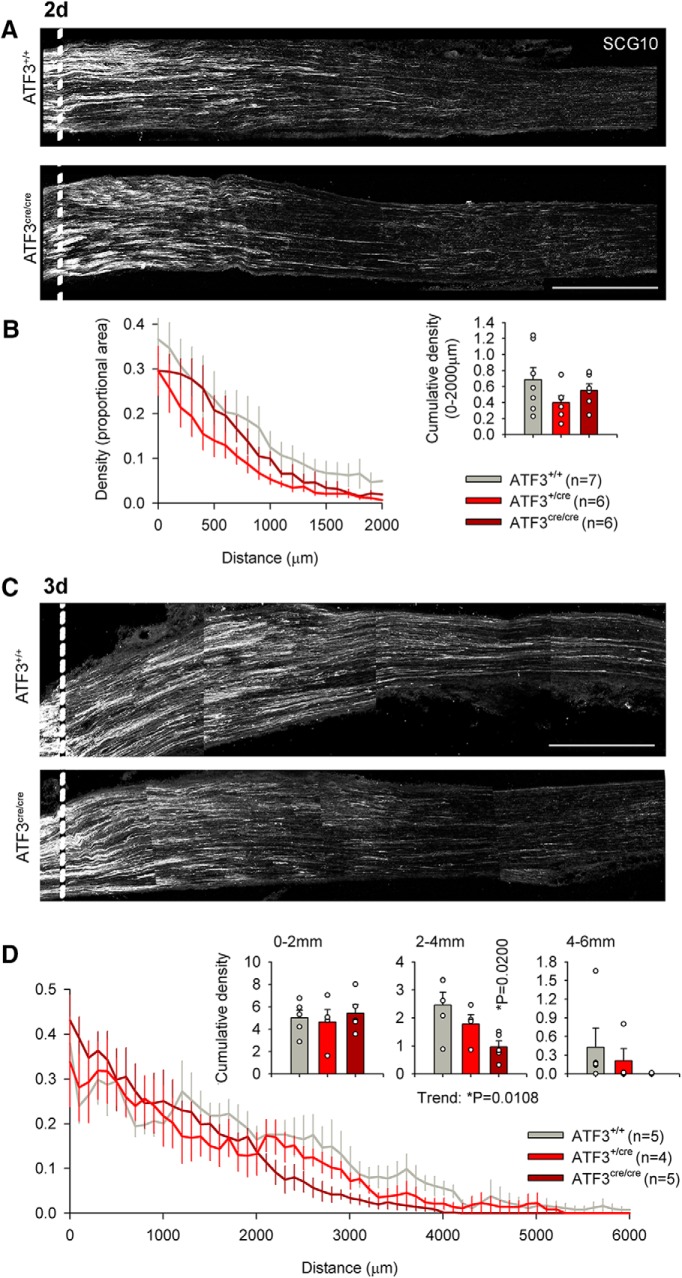
Loss of ATF3 function modestly reduces axonal regeneration following sciatic nerve crush. A, B, There was no difference in axonal regeneration 2 d following injury between ATF3+/+, ATF3+/cre, and ATF3cre/cre mice (n = 7, n = 6, and n = 6, respectively, groups were compared with a one-way ANOVA on cumulative densities). C, D, ATF3cre/cre mice exhibited significantly diminished axonal regeneration 3 d following injury 2–4 mm distal to the injury compared to ATF3+/+ mice (n = 5 for both groups, one-way ANOVA followed by Dunnett’s multiple comparison test). The hemizygous group (n = 4) tested positive as a significant intermediary between both control and ATF3 null groups (post hoc test for trend). Dotted line indicates distal border of crush site, 500 μm from the edge of the block. Scale bars: 500 μm.